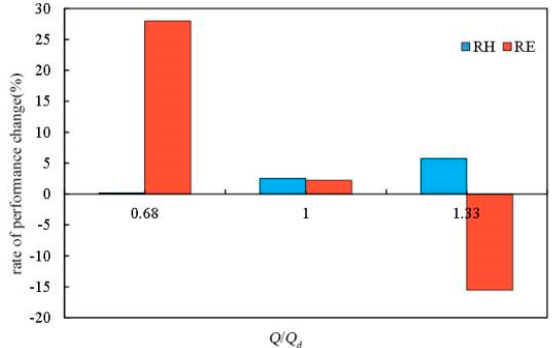
15 of 29 ( c ) Figure 17. Particle movement trajectories in the calculation domain: ( a ) 0.68 Q d ; ( b ) 1.0 Q d ; ( c ) 1.33 Q d .